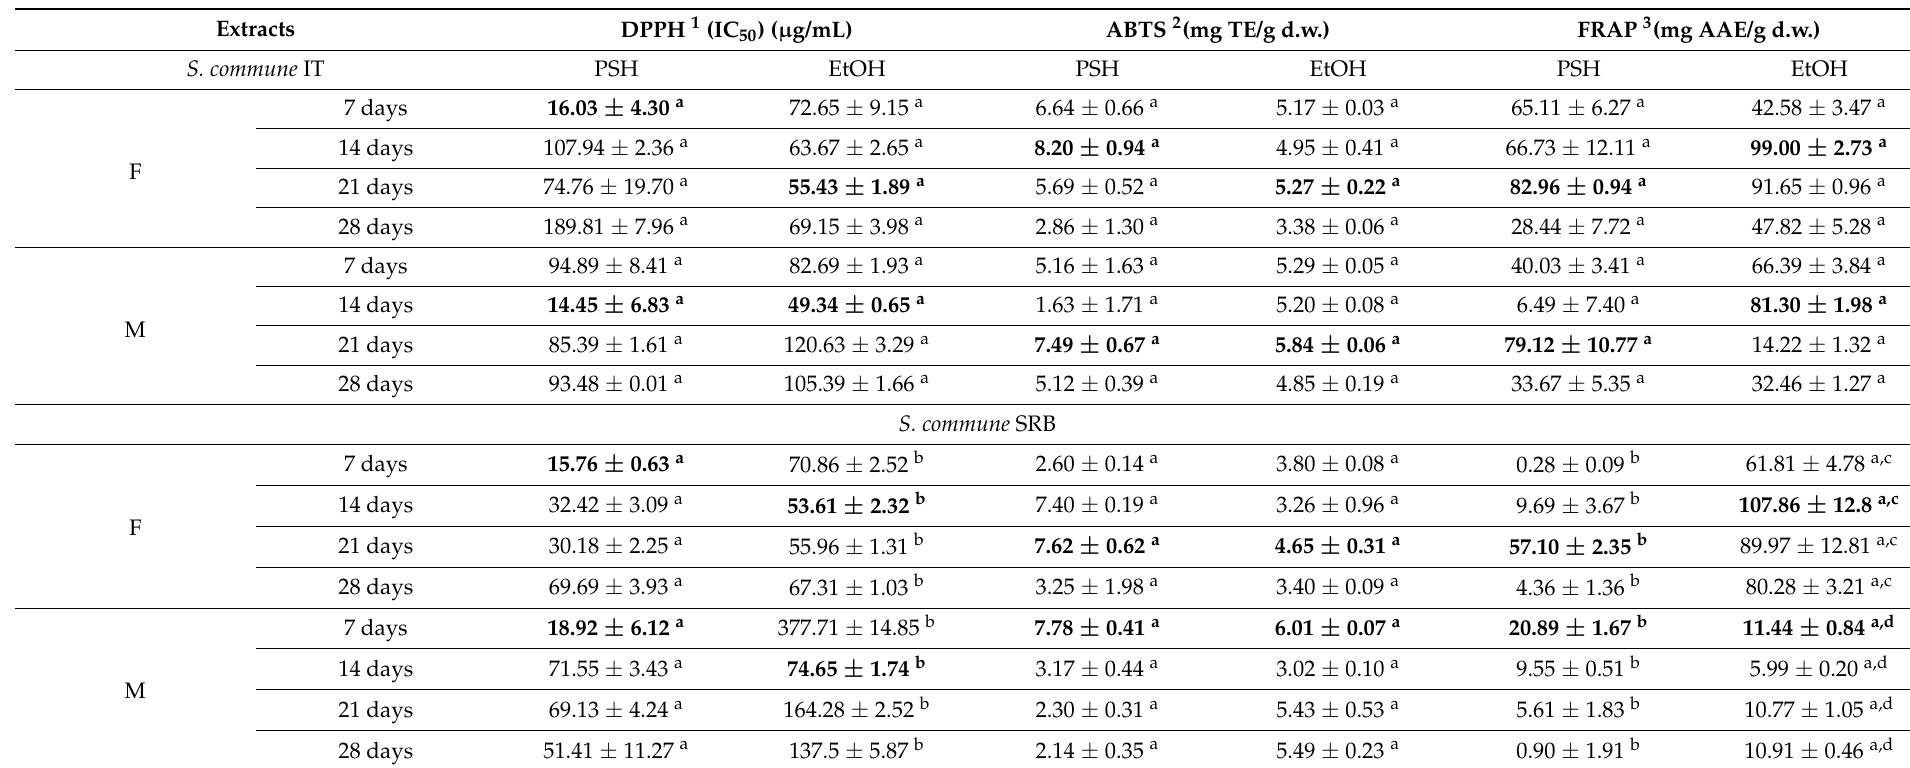
Table 1. Comparative review of the antioxidant activity (AO) of submerged polysaccharide (PSH) and ethanol (EtOH) extracts of S. commune —28 days—incubation time; DPPH—DPPH assay; ABTS—ABTS assay; TE—Trolox equivalents; FRAP—FRAP assay; AAE—ascorbic acid equivalents.